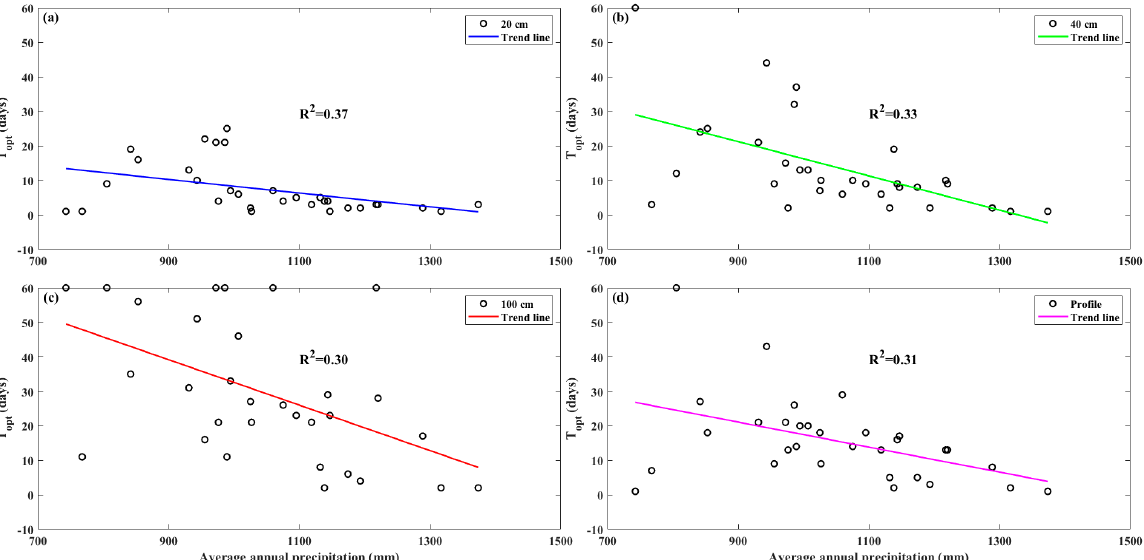
Figure 8. Scatter plots between T opt and average annual precipitation over all stations at depths of 20 ( a ), 40 ( b ), 100 ( c ) and profile average value ( d ), each circle represents a soil moisture station, color lines represent the trends of the scattered points.